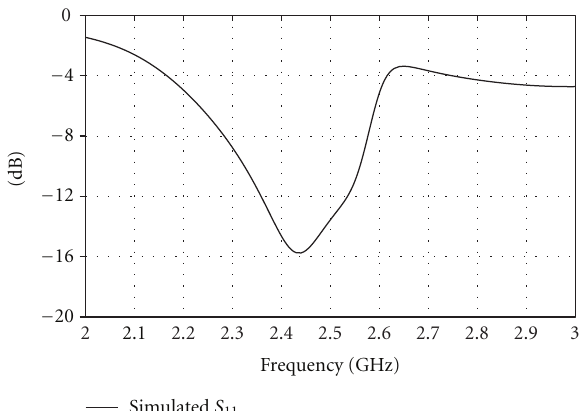
Figure 11: Simulated return loss of the dipole antenna with reflector and 4